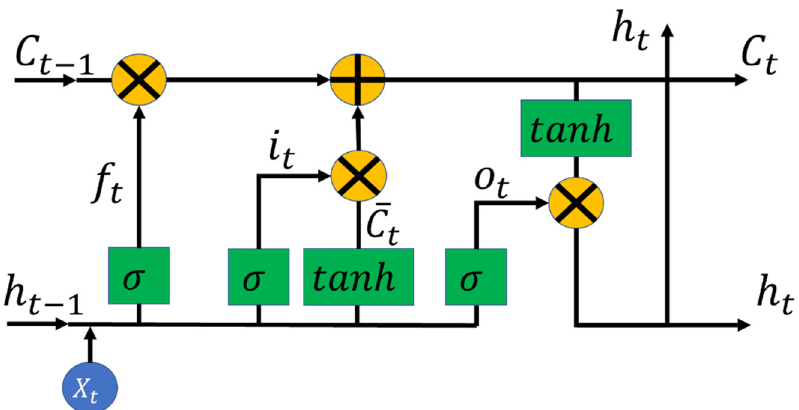
Figure 8. LSTM cell